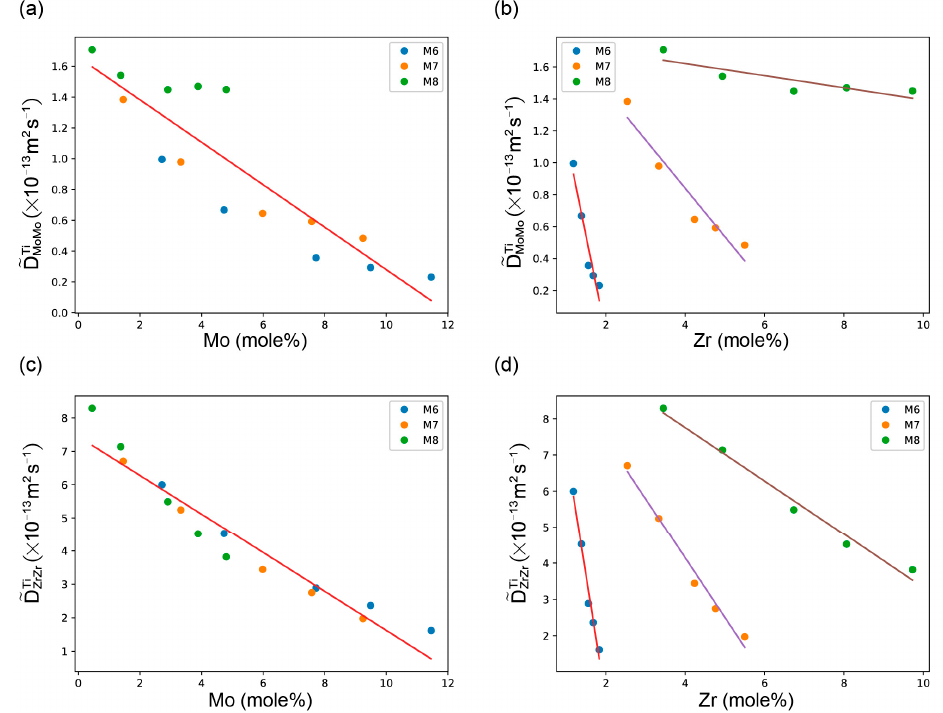
 Ti D with  Ti with D with MoMo MoMo MoMo